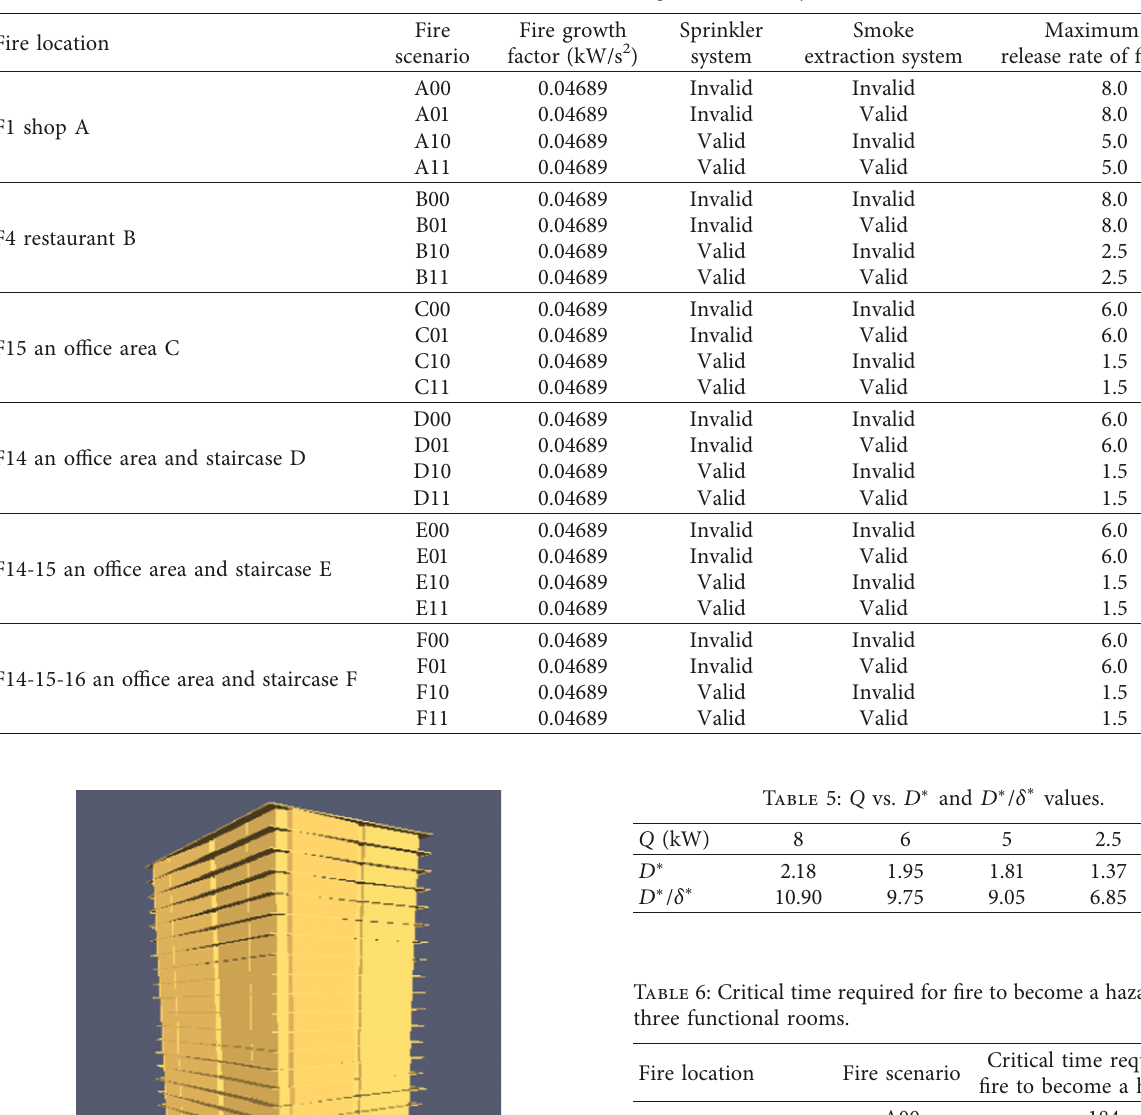
Table 4: Fire scenario design for this study.